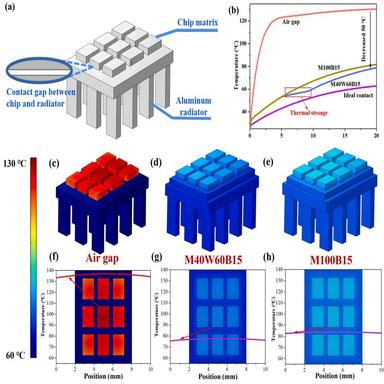
(a) Schematic diagram of the 3D finite element simulation of TIMs; (b) time–temperature curves of the entire chip matrix under different conditions: air gap, M40W60B15, and M100B15; temperature of the chip after working for 20 min under air gap (c, f), M40W60B15 sample (d, g) and M100B15 sample (e, h).